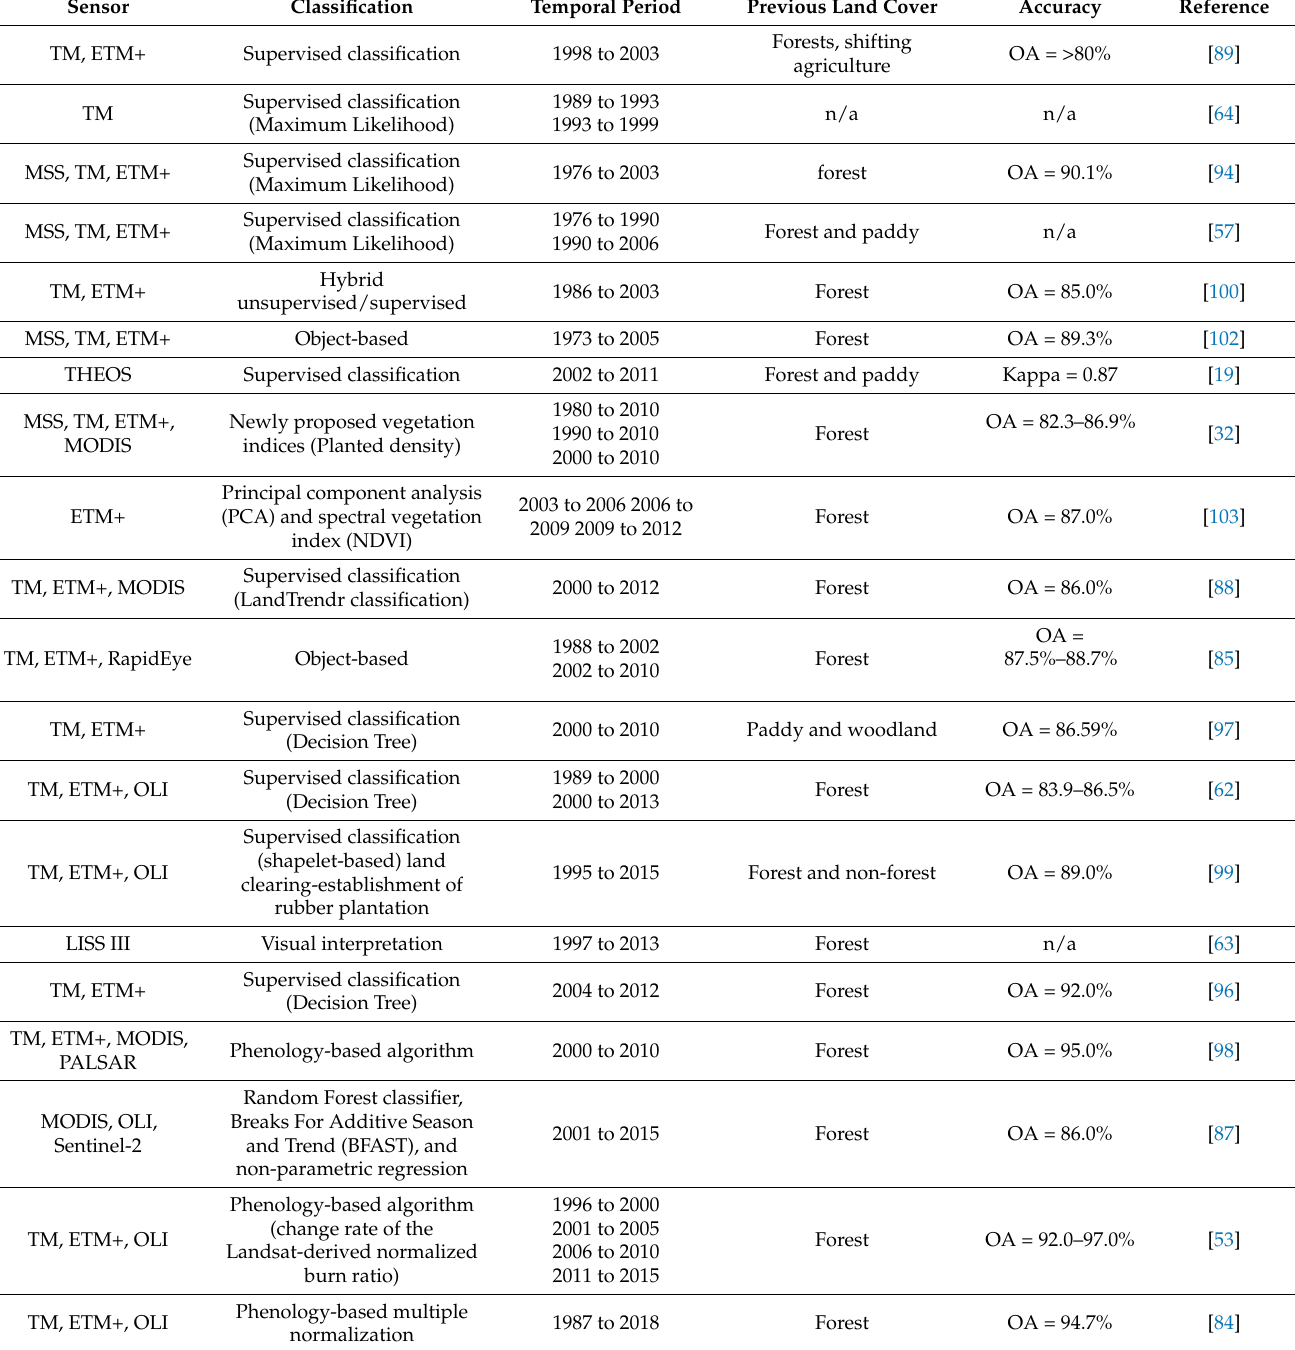
Table 5. Comparison of classification and overall accuracy for change detection studies in rubber plantations.